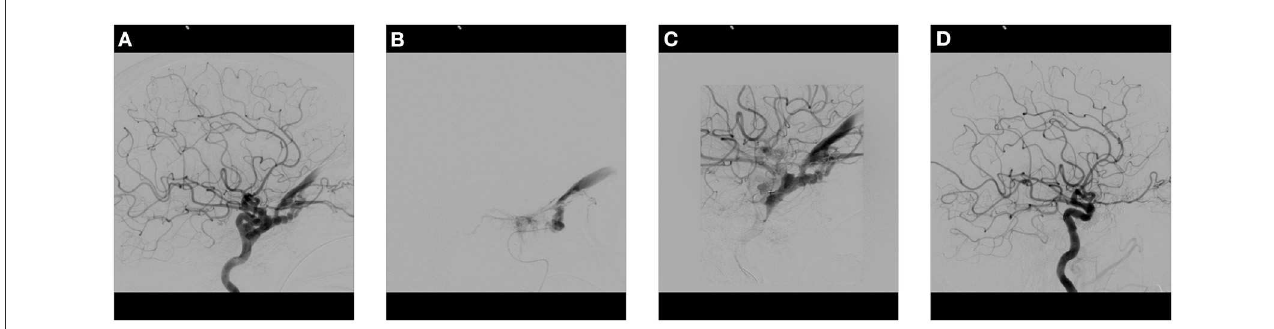
FIGURE1 Cranial angiogram of a patient with sudden onset of bulbar protrusion, chemosis and visual loss after a fall with skull base fracture. (A) Lateral DCA image of the left ICA demonstrates a direct CCF with massive arterialization of the cavernous sinus and dilatation of the superior ophthalmic vein and inferior petrosal sinus. (B) Transarterial placement of a microcatheter in the cavernous sinus. (C) Progressive filling of the cavernous sinus with multiple coils. (D) Post-therapeutic lateral control angiogram of the ICA demonstrates complete fistula occlusion without retrograde venous filling. CCF, Carotid cavernous fistula; DCA, Diagnostic cranial angiography; ICA, Internal carotid artery. (see legend in Figure 2).